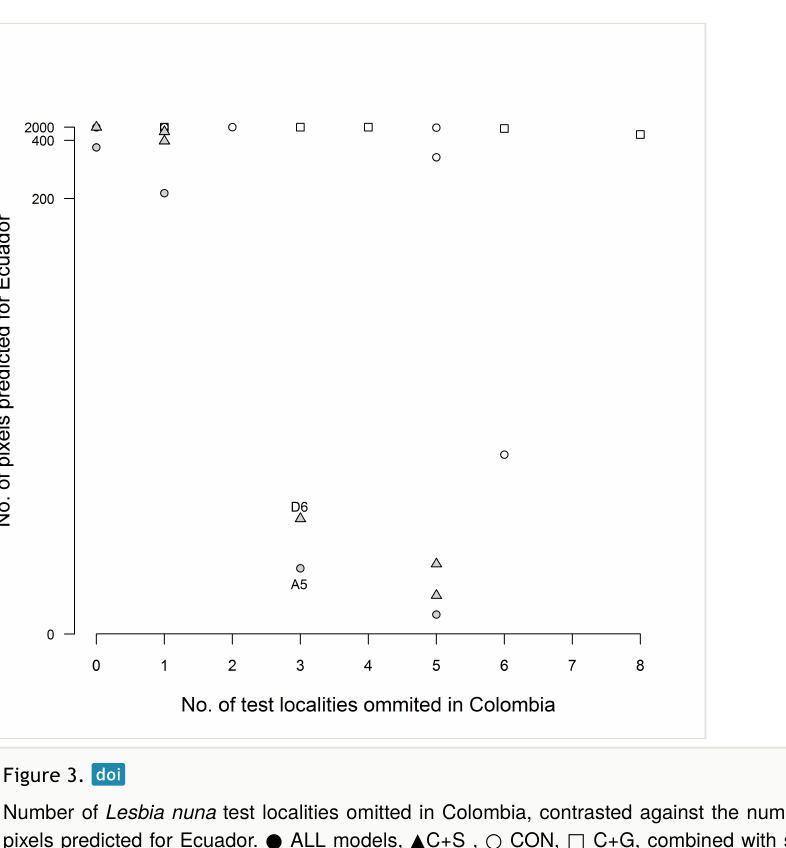
di ff erences: (1) only one combination performed di ff erentially better (C+S + X10 percentile training presence logistic threshold), (2) fewer, small and scattered patches of suitable areas predicted in Norte de Santander and (3) the same, but smaller, two patches of suitable areas predicted for Ecuador. This model also predicted some suitable areas for Venezuela similar to, but smaller than those described in the previous paragraph, excluding again “Sierra Nevada, Merida”.